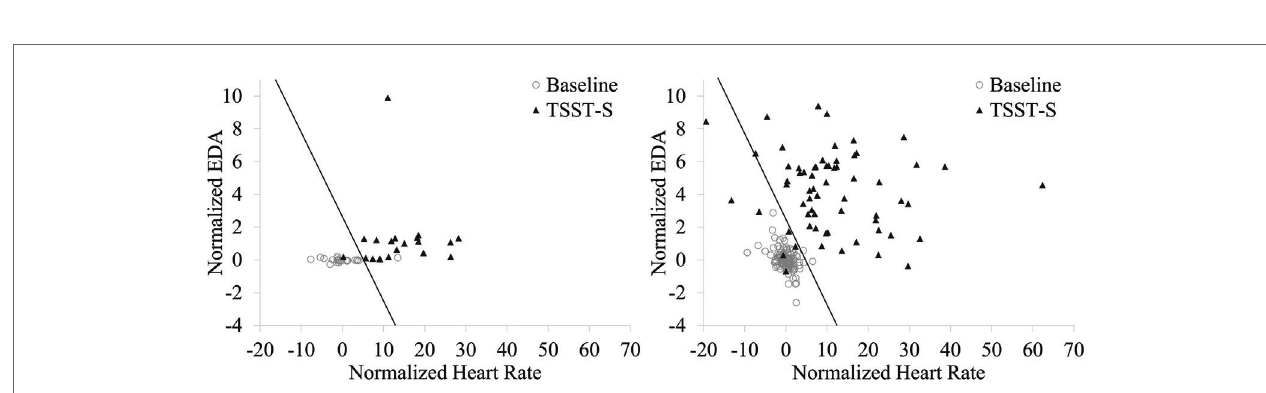
FigUre 2 | Task-dependent heart rate and skin conductance measures across participants . (left) Includes heart-rate estimate distributions; TSST-S, TSST-A, have notably high HR distributions, whereas baseline tends to be low. (right) includes electrodermal activity estimate distributions; the baseline conductance is relatively low, whereas TSST-S and TSST-A, are relatively high. Shown are group means ± SD.